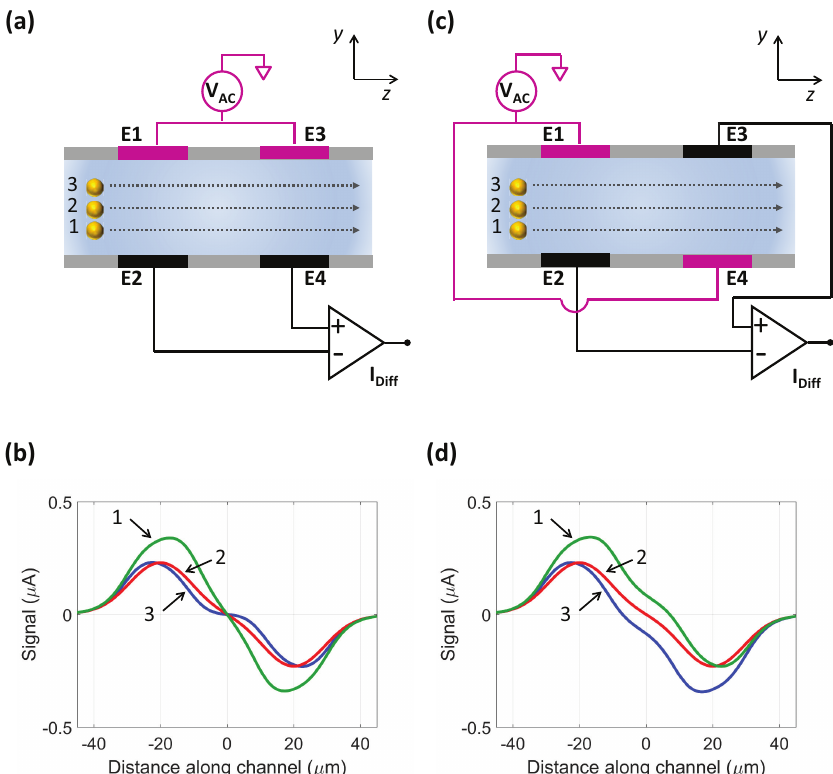
Figure 2. Facing electrode chip. ( a , c ) Side schematic view. Three particle trajectories are considered: in the lower half of the channel (trajectory 1), along the channel axis (trajectory 2), and in the upper half of the channel (trajectory 3). In ( a ) the conventional measuring scheme is shown: an AC voltage is applied to the top electrodes (E1 and E3) and the differential current flowing through the bottom (virtual ground) electrodes (E2 and E4) is measured. In ( c ) the novel measuring scheme is presented: an AC voltage is applied to diagonally opposite electrodes (E1 and E4), and the differential current flowing through the remaining (virtual ground) electrodes (E2 and E3) is measured; ( b , d ) Signal traces (finite element simulations) respectively recorded using the wiring schemes in ( a , c ). Insulating beads (6 µ m diameter) traveling along trajectories 1, 2, or 3 shown in panels ( a , c ) are considered (5 µ m gap from channel floor (respectively, ceiling) in trajectory 1 (respectively,